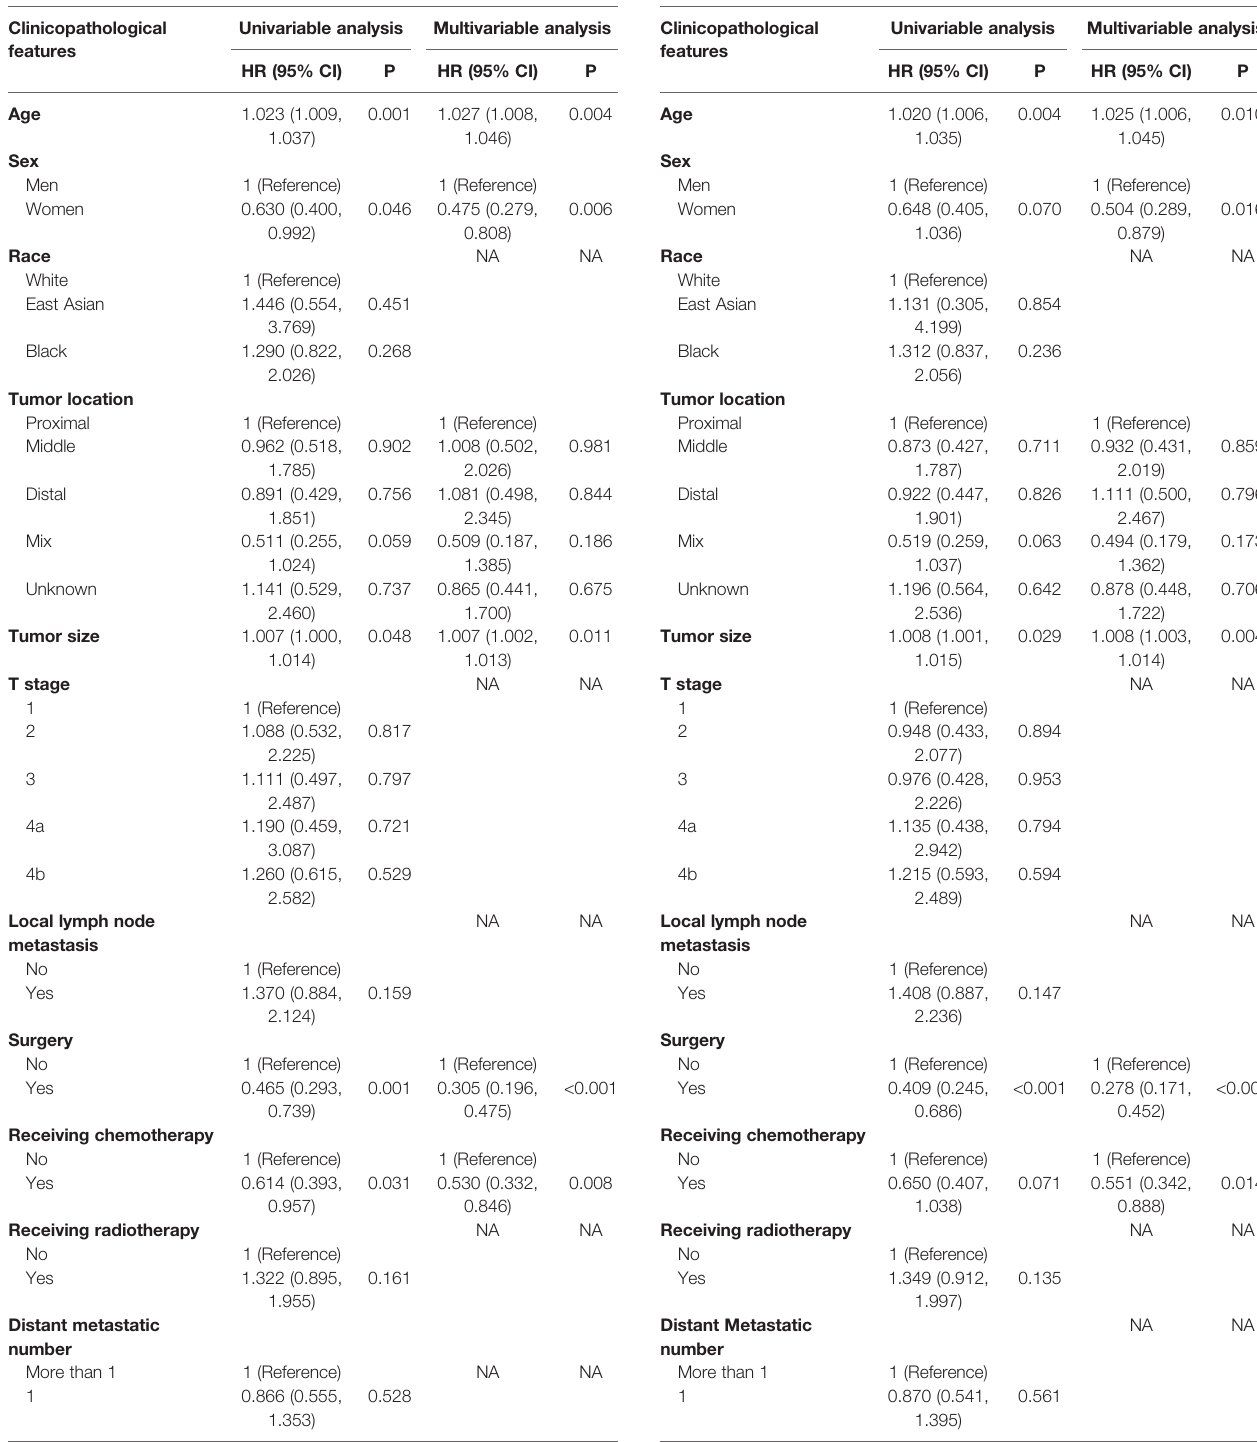
TABLE 3 | Univariable and multivariable cox regression analyses of factors associated with overall survival of patients with stage IV gastric neuroendocrine carcinoma in the Weighted Study Population.